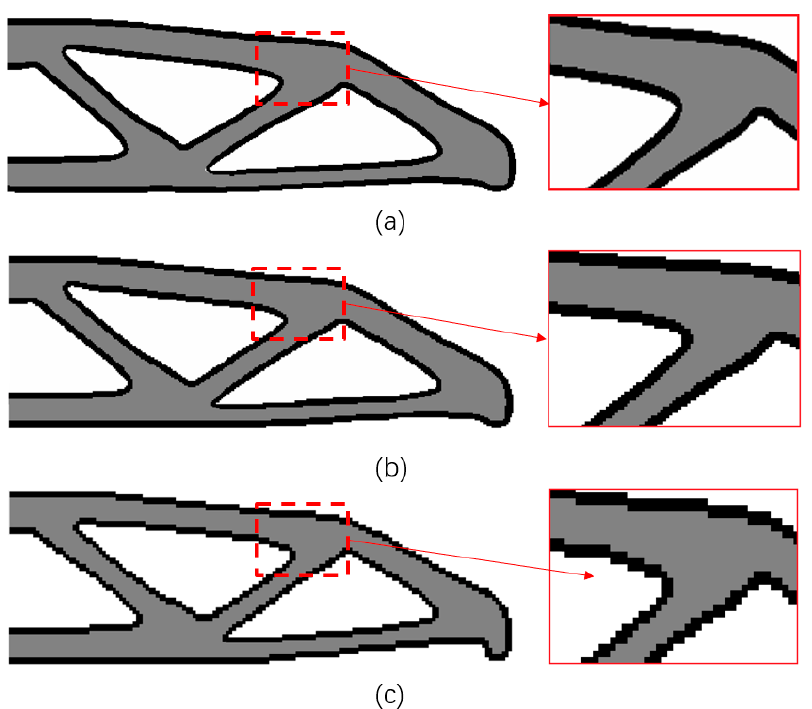
Figure 12. The optimized results with different mesh with the same boundary width: ( a ) 450 × 150 elements, C = 83.0675; ( b ) 300 × 100 elements, C = 88.3850; ( c ) 150 × 50 elements, C = 97.2552 .